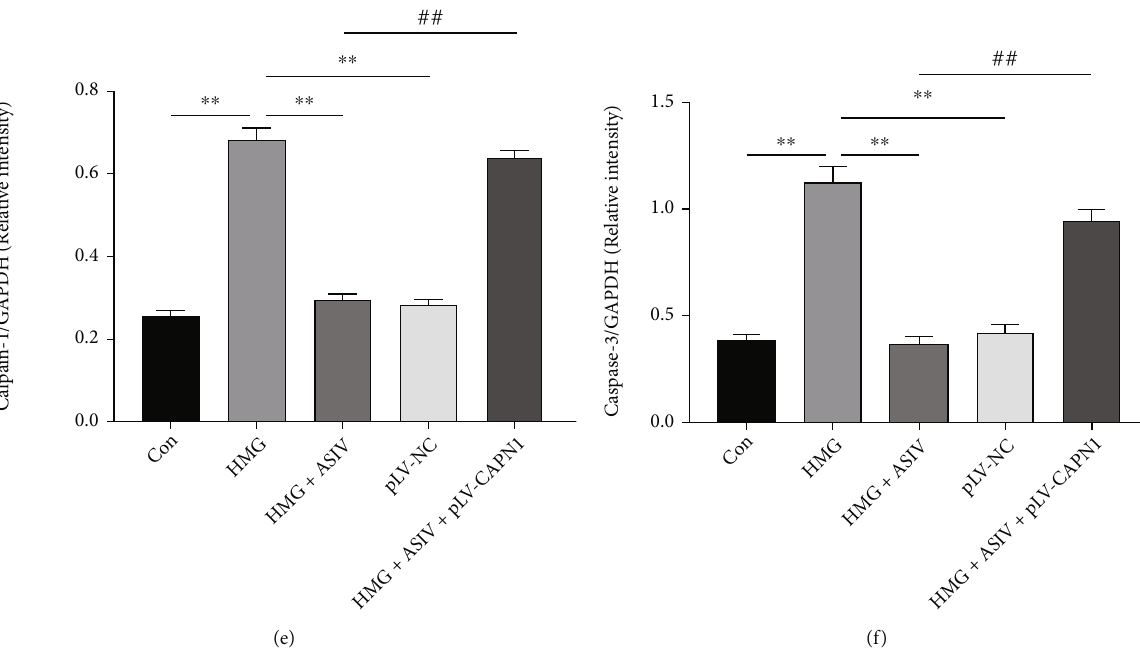
Figure 9: AS-IV inhibits calpain-1 overexpression and attenuates hypoxia-induced oxidative stress and apoptosis in HT22 cells. (a) The cell viability of each group was detected by CCK-8 assay ( n = 4 ; F ð 4,15 Þ = 126 : 041 ). (b, c) Changes in SOD and MDA were detected with kits ( n = 4 ; SOD, F ð 4,15 Þ = 38 : 705 ; MDA, F ð 4,15 Þ = 102 : 154 ). (d – f) Western blotting was used to detect caspase-3 and calpain-1 protein expression ( n = 3 ; calpain-1, F ð 4,10 Þ = 342 : 774 ; caspase-3, F ð 4,10 Þ = 160 : 375 ). Data are presented as the mean ± SD . ∗∗ P < 0 : 01 compared with the HMG group, ## P < 0 : 01 compared with the HMG +ASIV